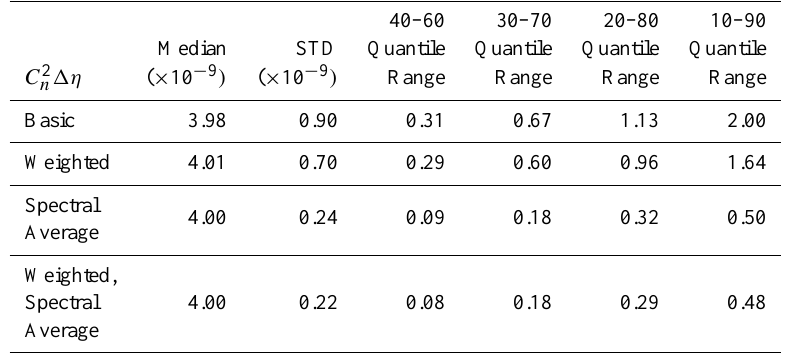
Table 1. Statistics for maximum likelihood estimates of C 2 n 1η .